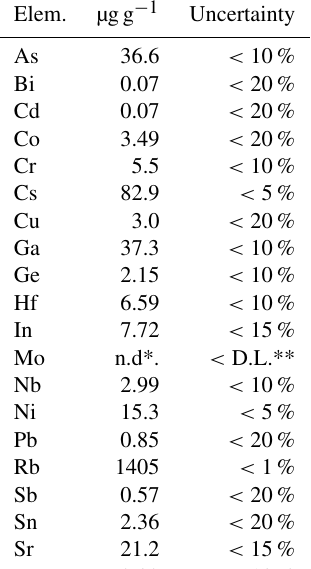
Table 2. WDS and ICP-OES-MS chemical analyses of laurentthom- asite.